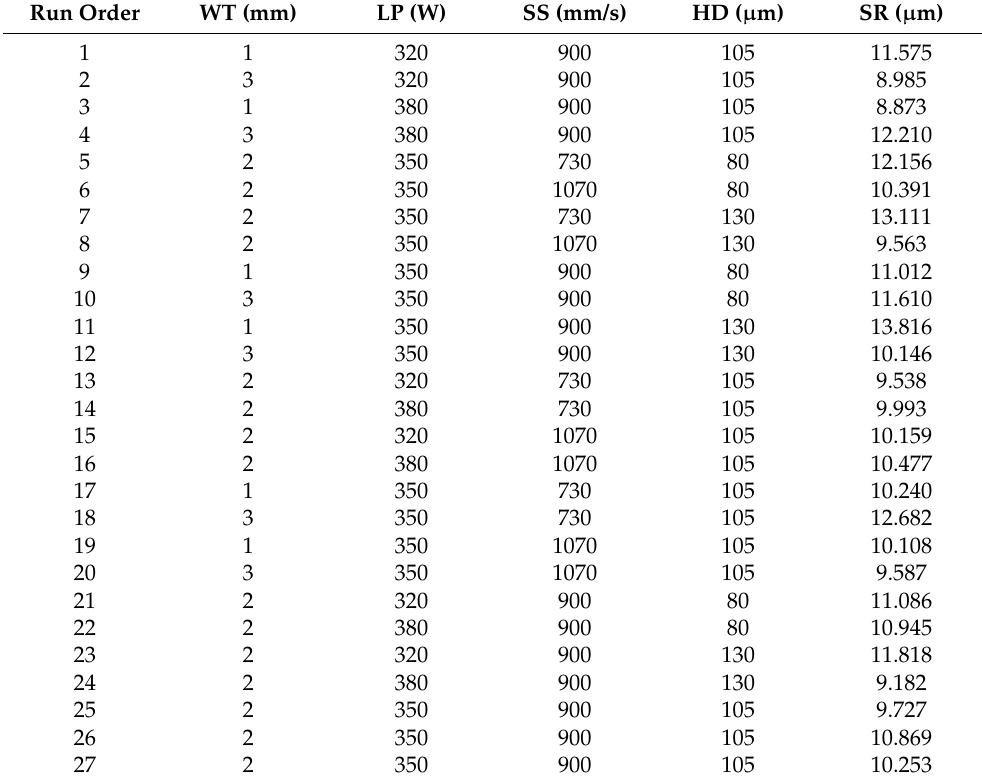
Table 4. Average SR values in As-built